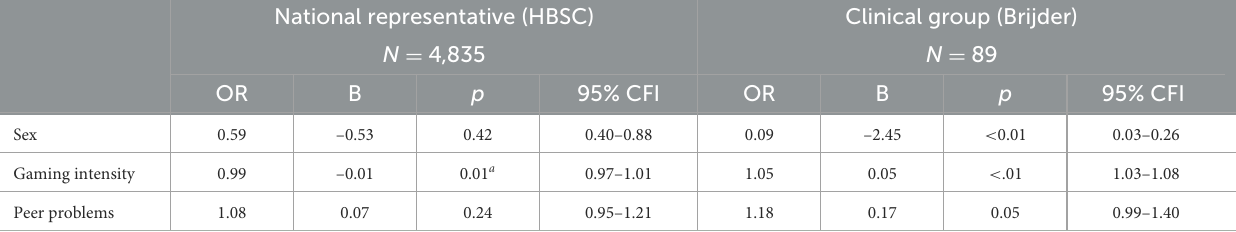
TABLE 5 Multinominal regression analyses with subsample as grouping variable, and sex, gaming and peer problems as